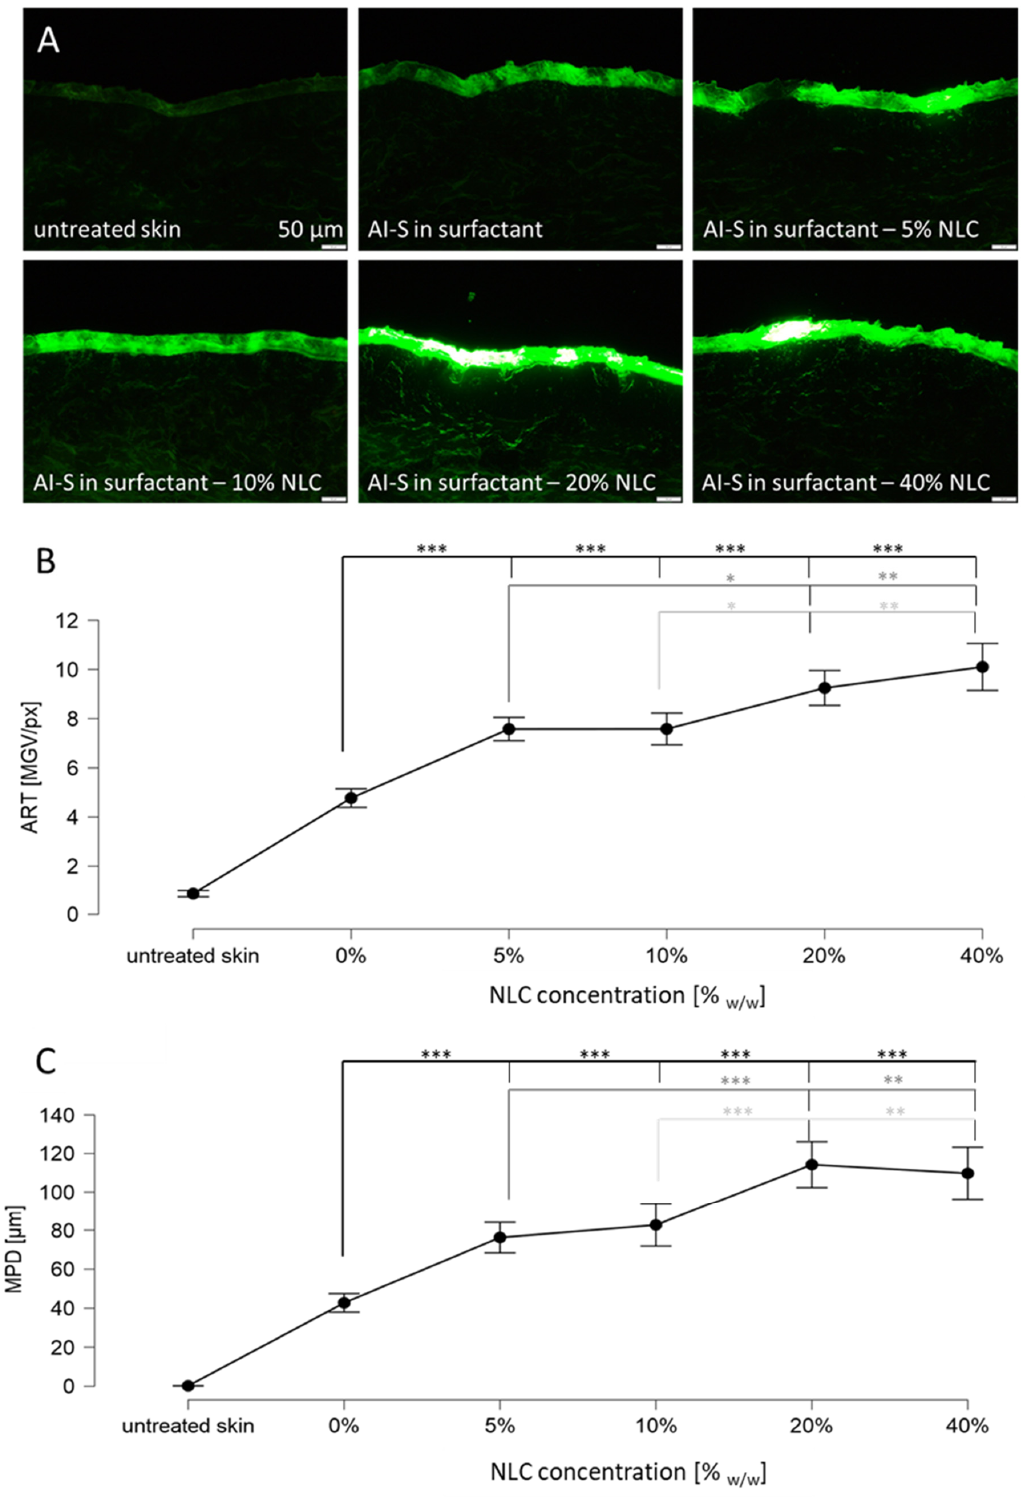
Figure 6. Dermal penetration efficacy of skin treated with sodium fluorescein solution with and without NLC particles. ( A ) Images of vertical skin sections obtained by inverted epifluorescence microscopy, ( B ) ART values as surrogate for the total amount of penetrated AI, ( C ) mean penetration depth (MPD). AI-S = AI surrogate = fluorescein. NLC = nanostructured lipid carriers. Untreated was significant in relation to all measured values. The asterisks indicate the following p -values: * ≤ 0.05; ** ≤ 0.01; *** ≤